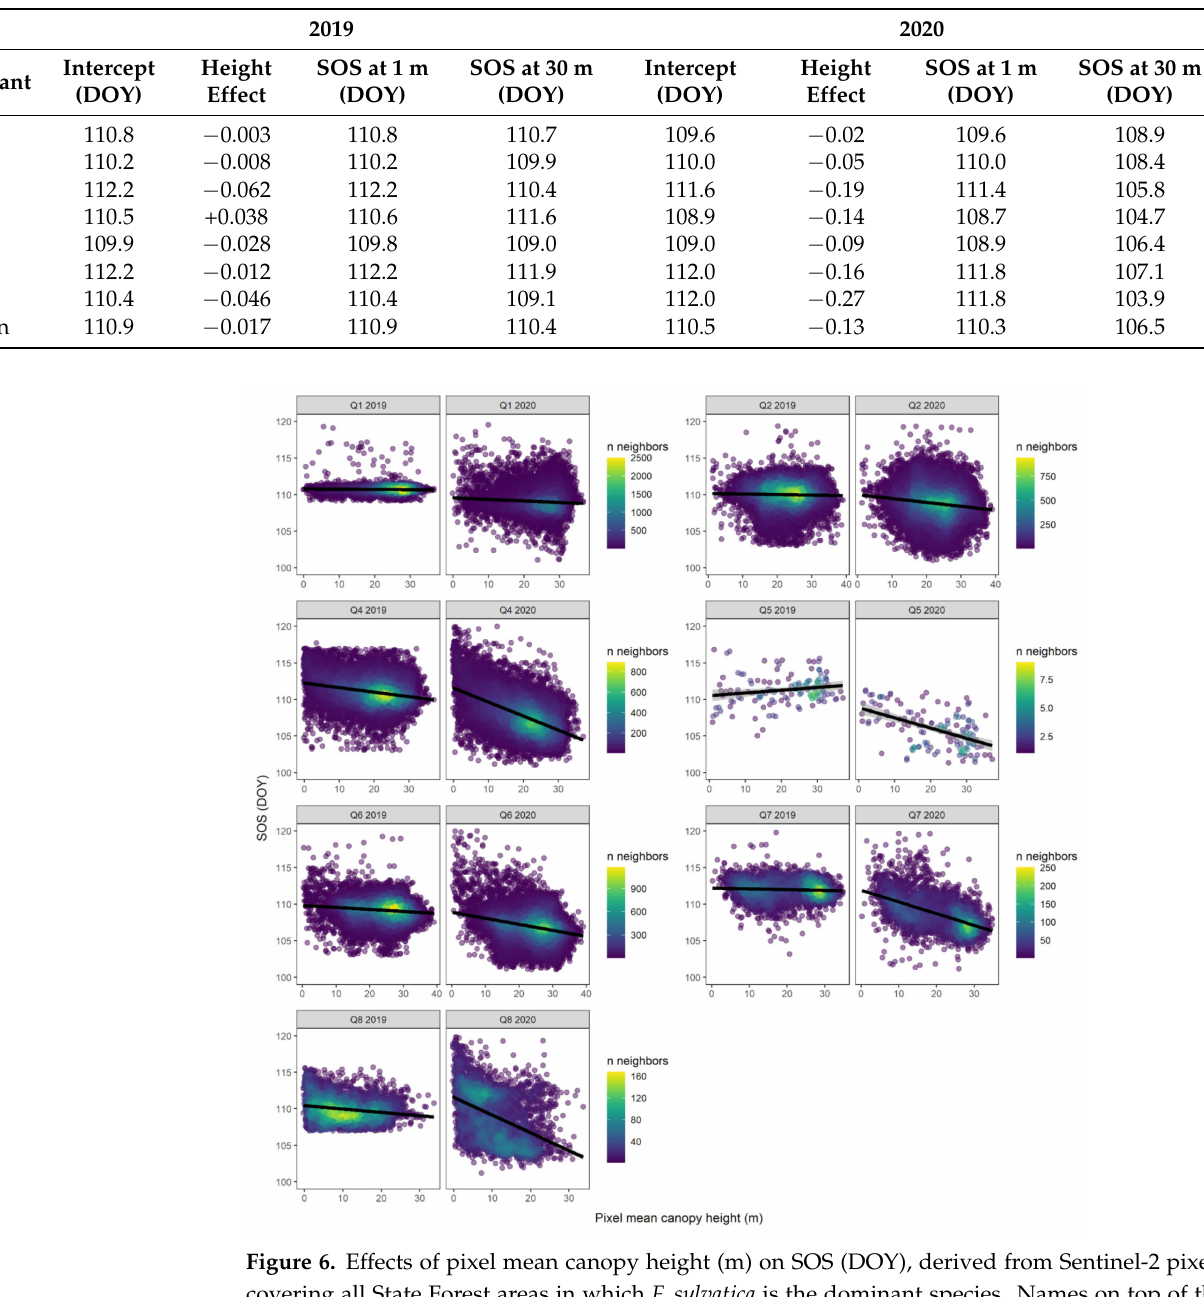
Table 3. Pixel mean canopy height effects from separate linear models per quadrant × year predicting Sentinel-2 SOS (Figure 6) and the resulting output for 1 m (understory height) and 30 m (adult tree height). Values under intercept, SOS at 1 m, and SOS at 30 m are in DOY. Height effect is the number of days the SOS is predicted to increase (+) or decrease ( − ) per m increase in pixel mean canopy height.